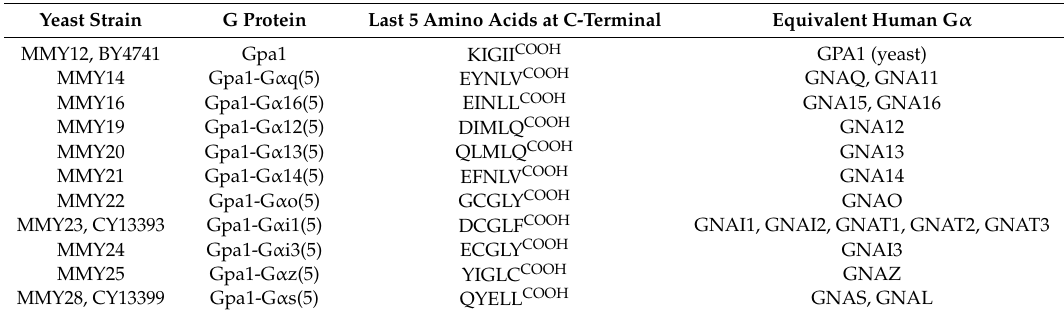
Table 2. List of yeast strains